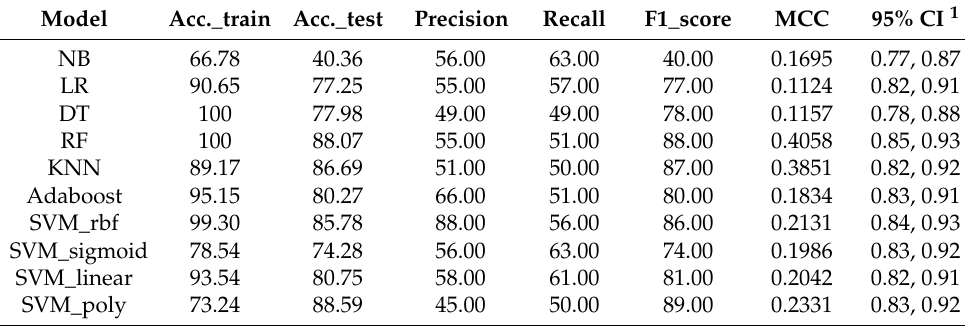
Table 3. Performance of ML models on balance data using all